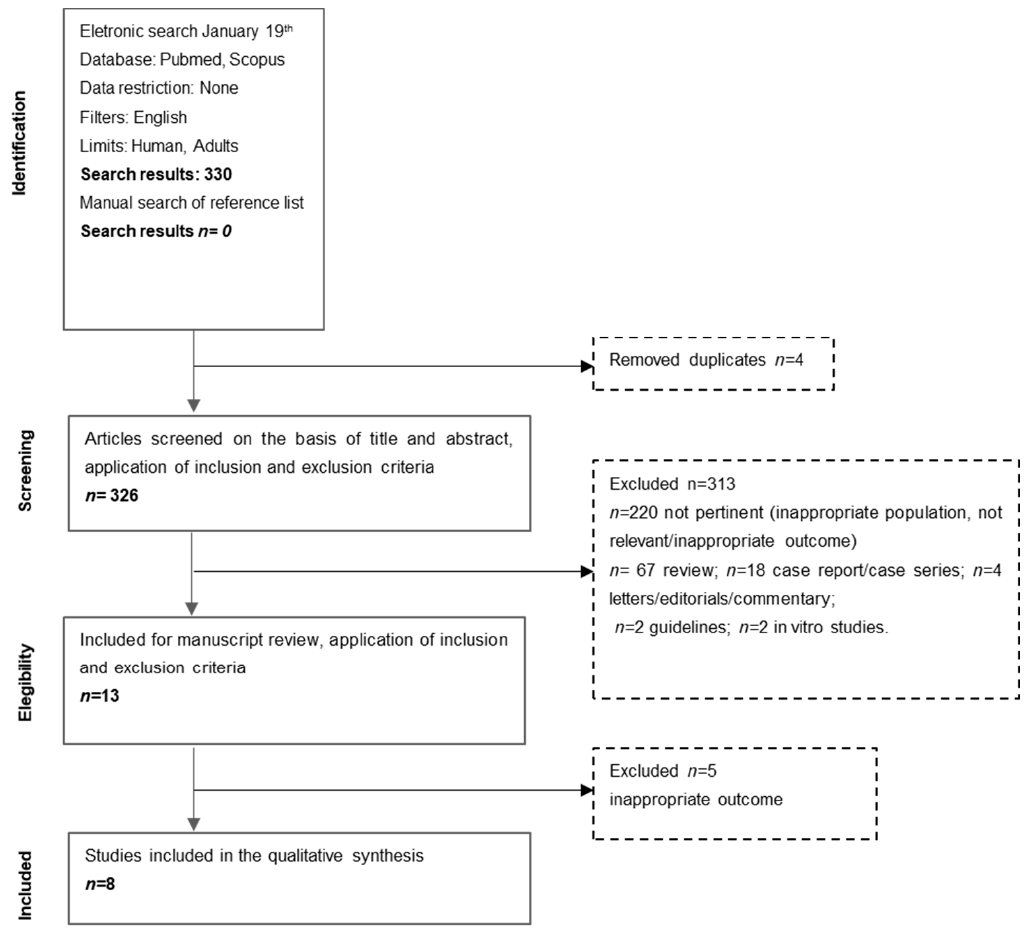
Figure 1. Flow-chart of study selection.